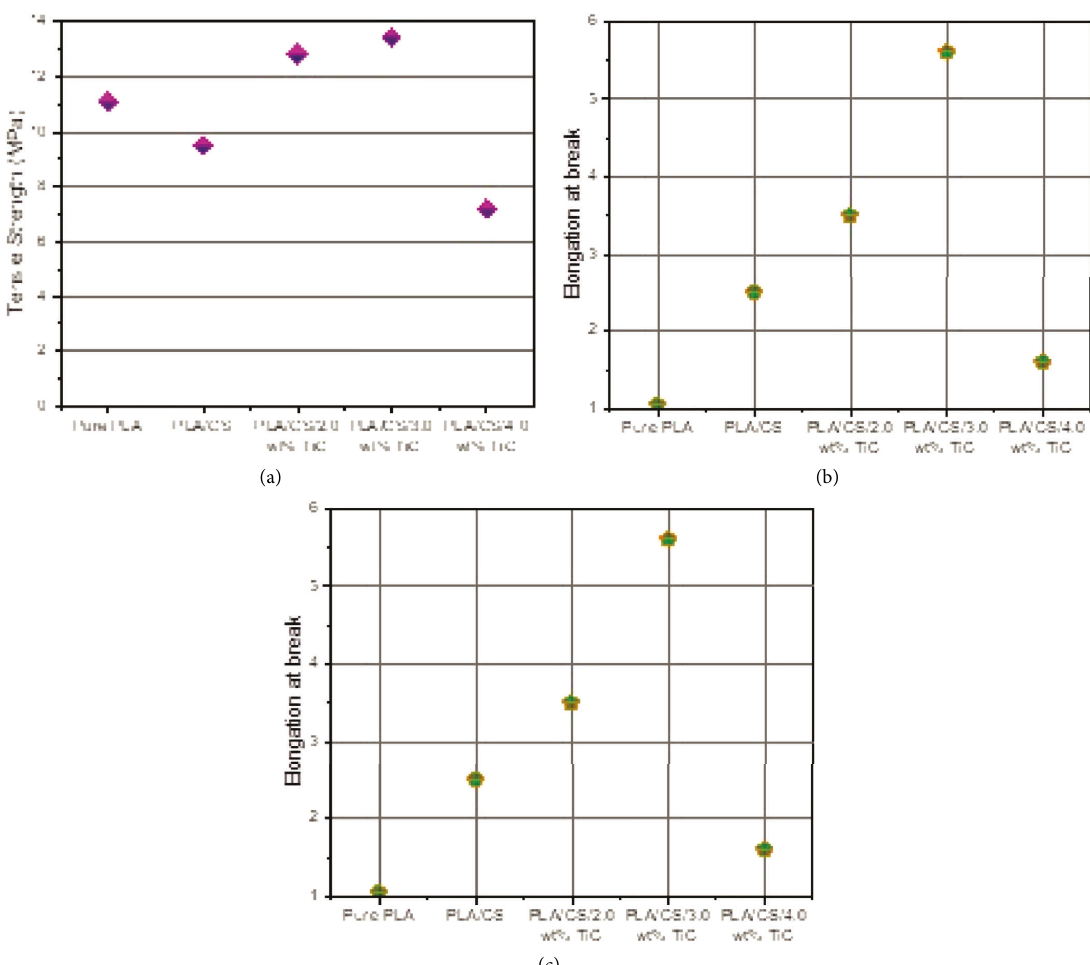
Figure 8: Typical stress-strain curve for pure polylactic acid/chitosan